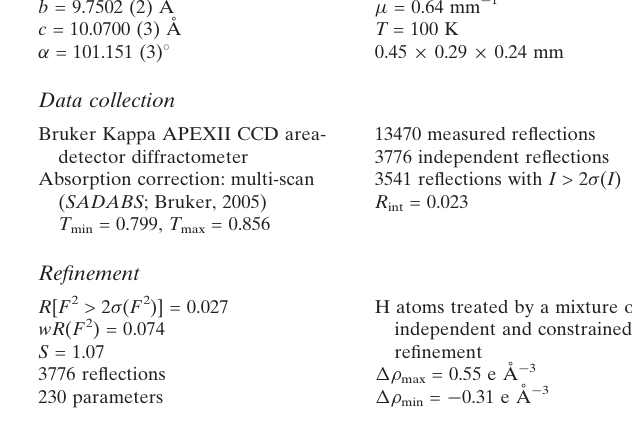
13470 measured reflections 3776 independent reflections